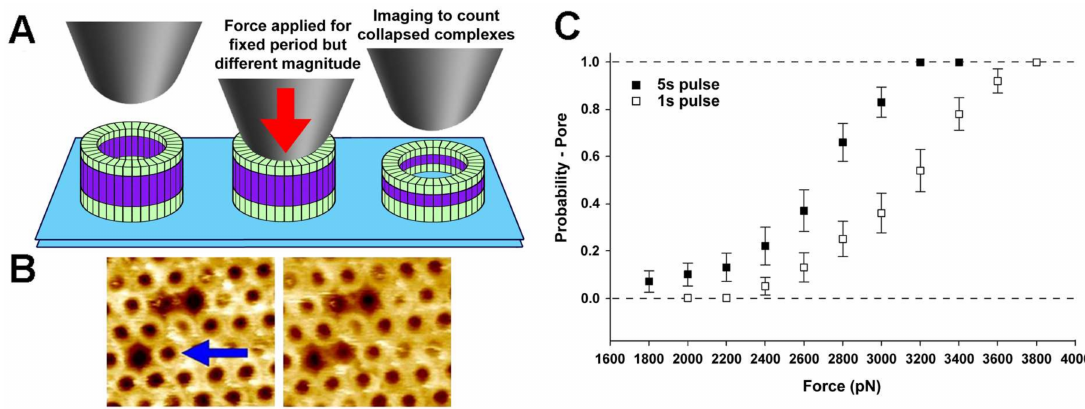
Figure 4. Single molecule CFS characterization of the pre-pore to pore transition in the pore-forming toxin, PFO. ( A ) Schematic diagram of the experiment, whereby a constant force in applied to pre-pore trapped complexes for a specific length of time (1 s or 5 s), followed by imaging at much lower forces to determine if the force was sufficient to catalyze the vertical collapse of the complex to the pore height; ( B ) Typical atomic force microscopy (AFM) images before (left) and after (right) the application of ~110 pN/monomer (~4000 pN) to a single pre-pore complex (blue arrow) Image size is 200 × 220 nm 2 ; ( C ) Force and time dependence of the pre-pore to pore height collapse, from which details of the energy landscape associated with this transition can be directly obtained. This image is adapted from Czajkowsky et al. published by eLife (2015)